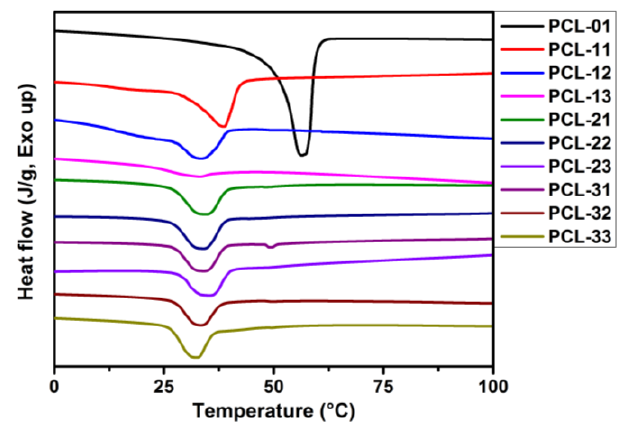
ff erential scanning calorimetry (DSC) curves of the PCL sca ff olds (second heating Figure 1. Differential scanning calorimetry (DSC) curves of the PCL scaffolds (second heating cycle). Figure 1. Di